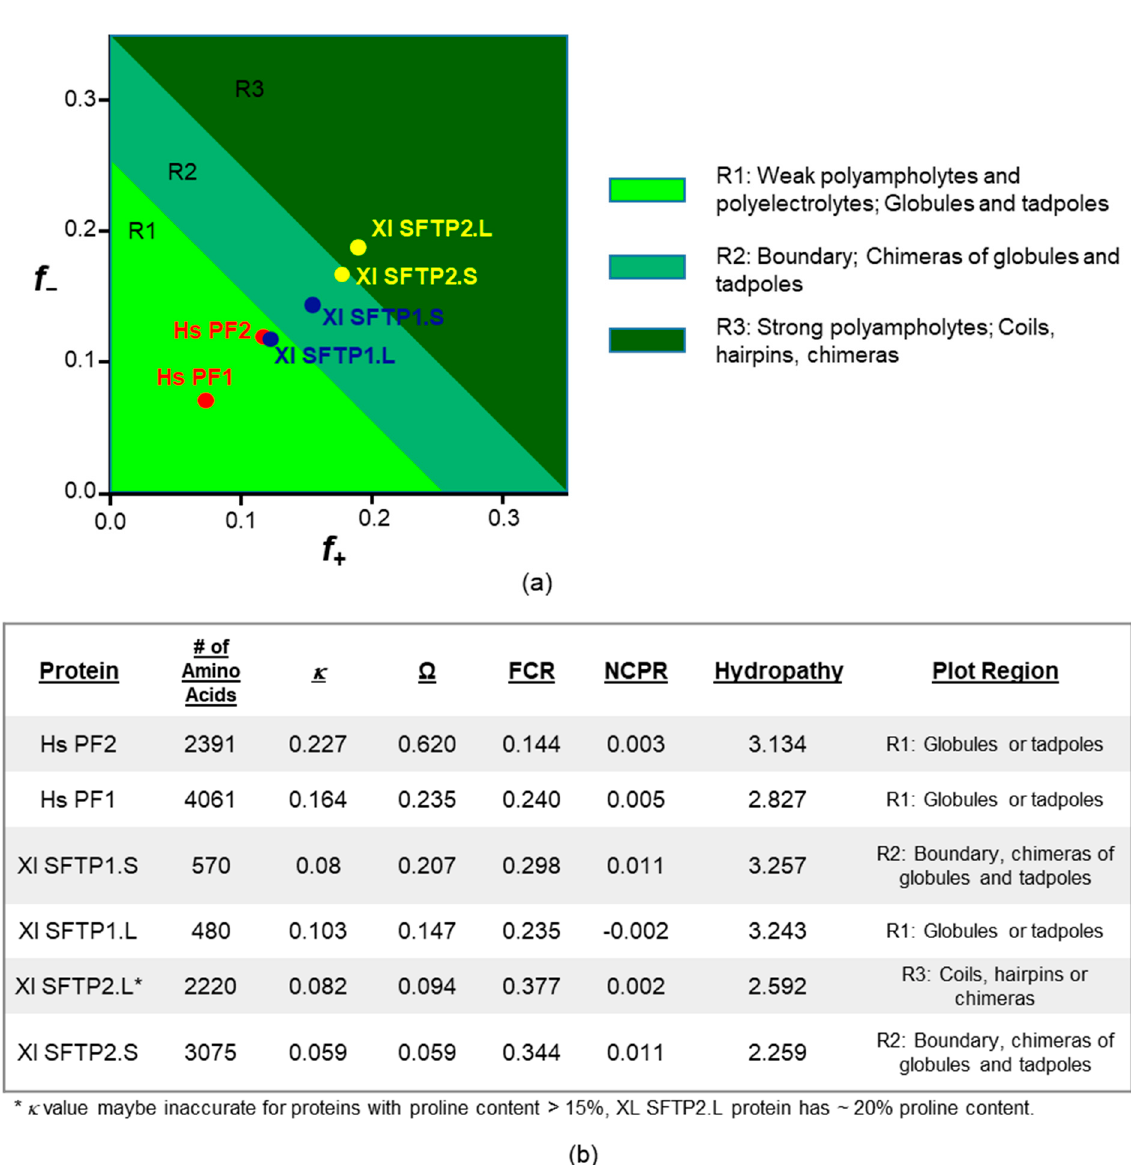
Figure 6. Output of CIDER analysis of human and Xenopus SFTP proteins. ( a ) Das–Pappu diagram of states depicting the proposed structural conformation for each protein based on the fraction of positive ( f +) and negative ( f − ) charged residues. ( b ) Proteins are sorted in the table according to their Ω values. Human profilaggrin (Hs PF1) and filaggrin (Hs PF2) (red dots) have the lowest fraction of charged residues, placing them into the R1 region of the diagram, implying they adopt a globular or tadpole-like shape. The Xenopus SFTP 1.L and SFTP 1.S proteins (blue dots) fall into regions R1 and R2, respectively. Proteins that occupy region 2, or the boundary region, assume an ensemble of states between those of R1 and R3. The Xenopus SFTP 2.S and SFTP 2.L (yellow dots) lie adjacent to and firmly in R3, meaning they have the potential to fold into hairpin or coiled conformations. FCR, fraction charged residues; NCPR, net charge per residue.